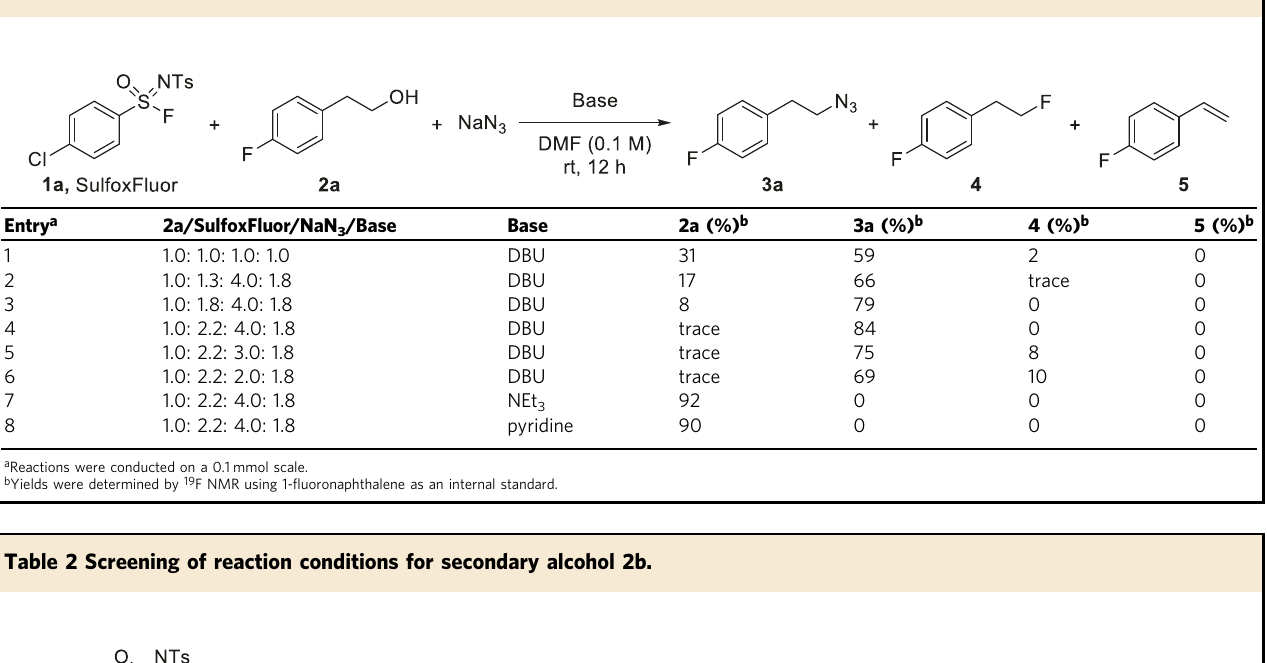
Table 1 Screening of reaction conditions for primary alcohol